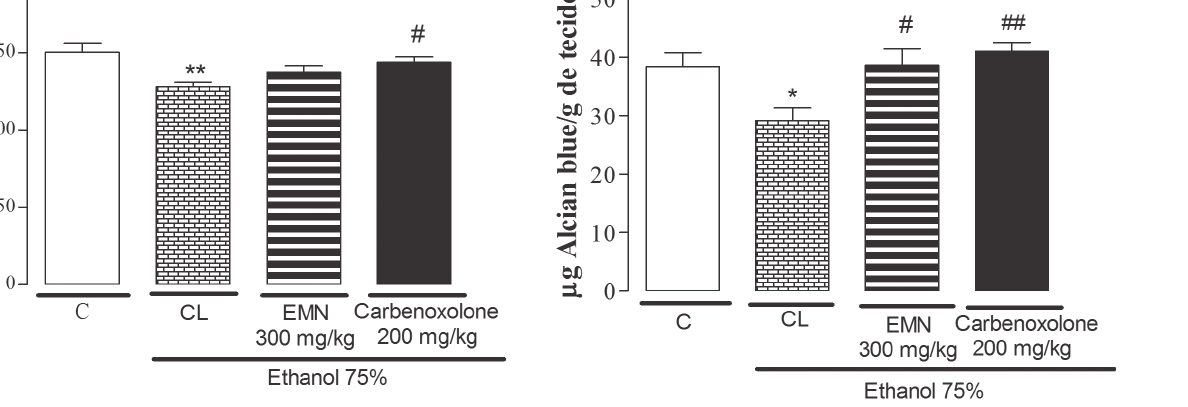
Figure 2 - Effect of ethanolic root extract of Memora nodosa (EMN) on GSH gastric levels. Results were expressed as Mean ± SEM. n = 9. Data were analyzed by ANOVA followed by Newman-Keuls test. **p < 0.01 compared with control group (C). # p < 0.05 compared with control group with lesion